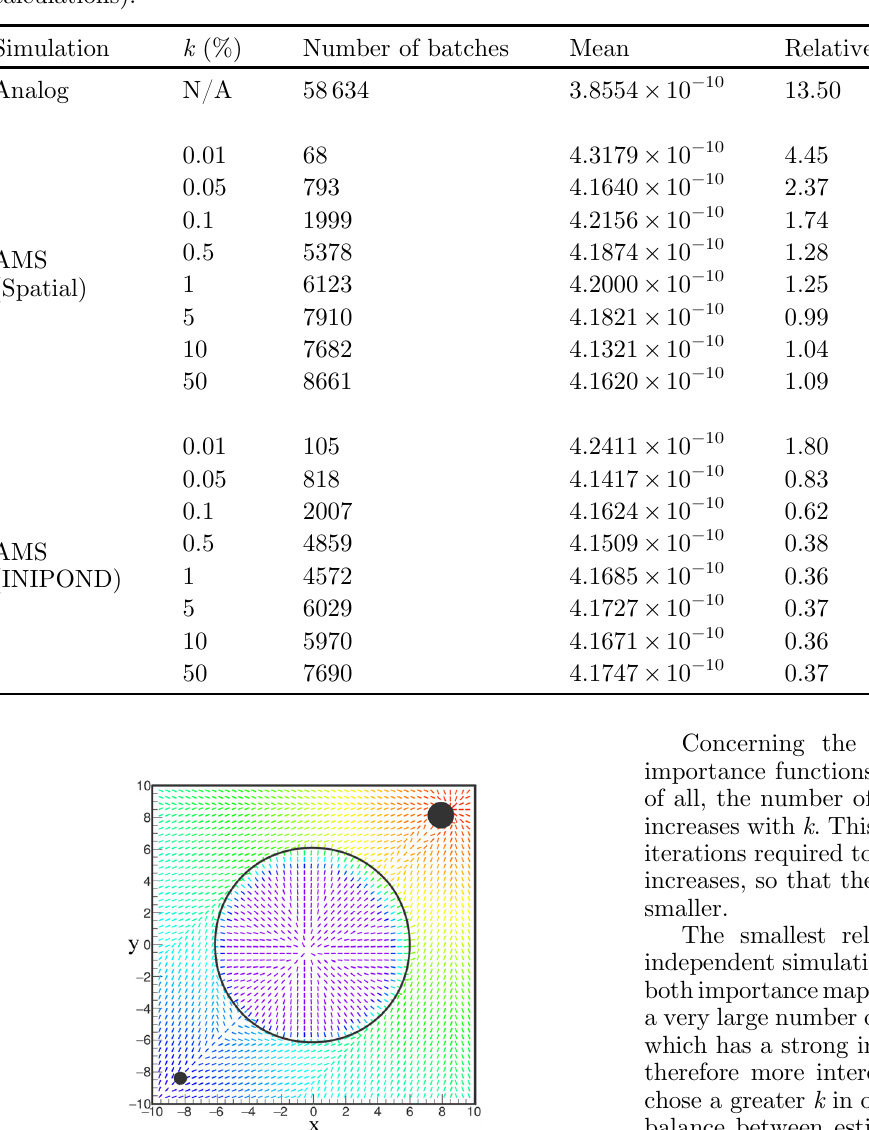
Table 1. Comparison of TRIPOLI-4 ® with and without AMS for fl ux estimation in the bypass geometry (48 h calculations).